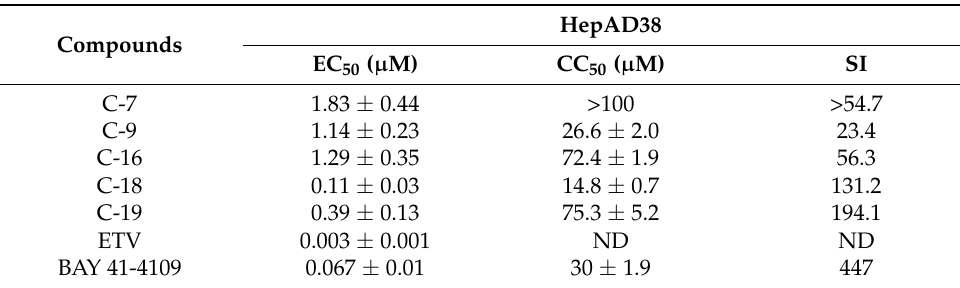
Table 1. The anti-HBV activity of C-7, C-9, C-16, C-18, C-19, ETV, and BAY 41-4109 in stable HBV- replicating HepAD38